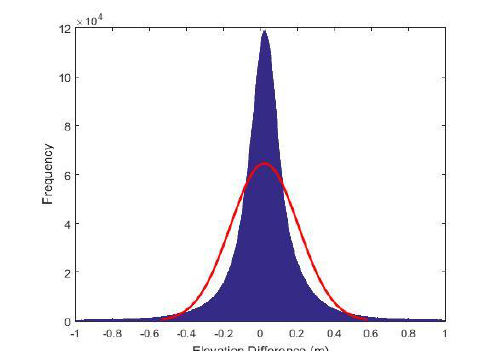
Figure 3. Distribution of the elevation differences whose absolute values are below 1m To assess the influence of image downsampling on the UAV photogrammetry, results of image matching and image orientation are compared between the original and the downsampled images. Data collected at surveying area B is used for the experiment. The rectangle-like surveying area is 6 km from east to west and 7 km from south to north (Figure 4). The elevation of the area is in the range of 200-1050 meters above the sea level. Most of the surveying area is covered by shrubs and trees.